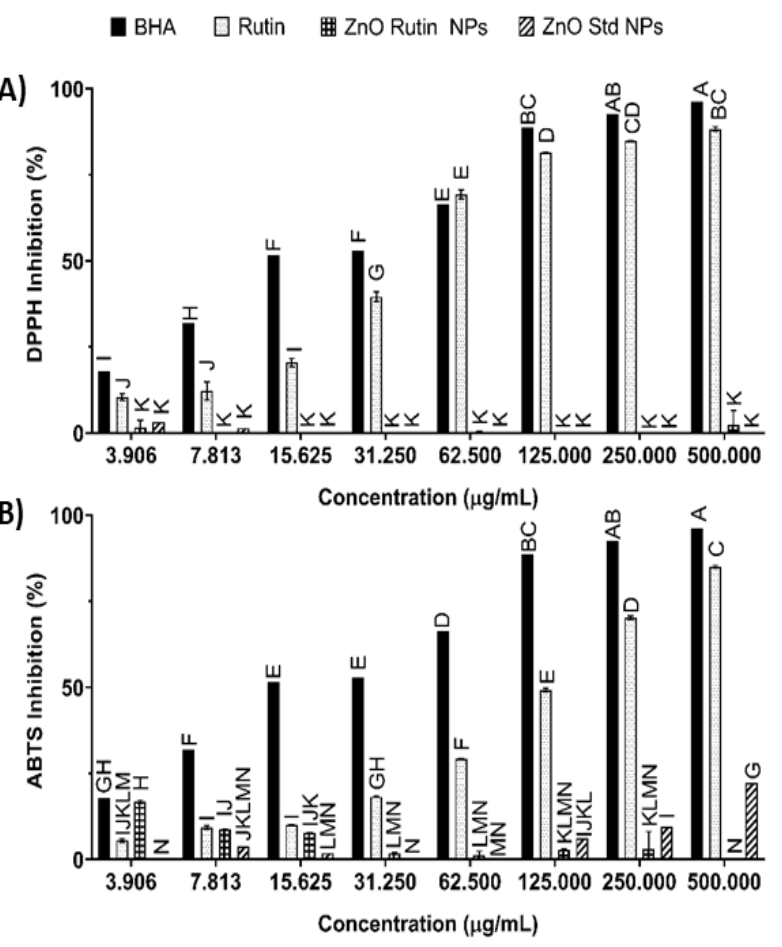
Figure 6. ( A ) DPPH and ( B ) ABTS assays. Samples with different letters differ significantly ( p < 0.05, mean ± SD, n = 3).